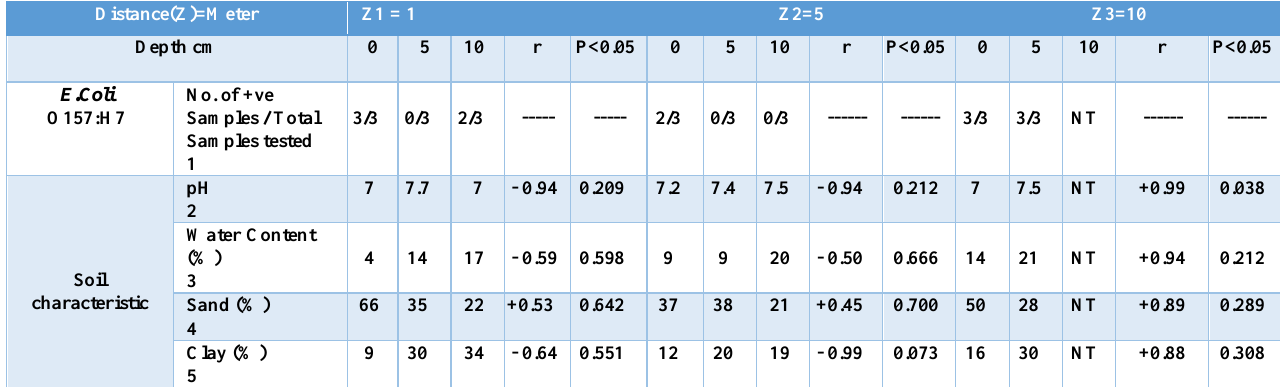
0=Surface, NT=Not tested (tilled land), 1=Prevalence, 2=pH, 3=Water contents%, 4=Sand%, and 5=Clay% Correlation = 1×2, 1×3, 1×4, and